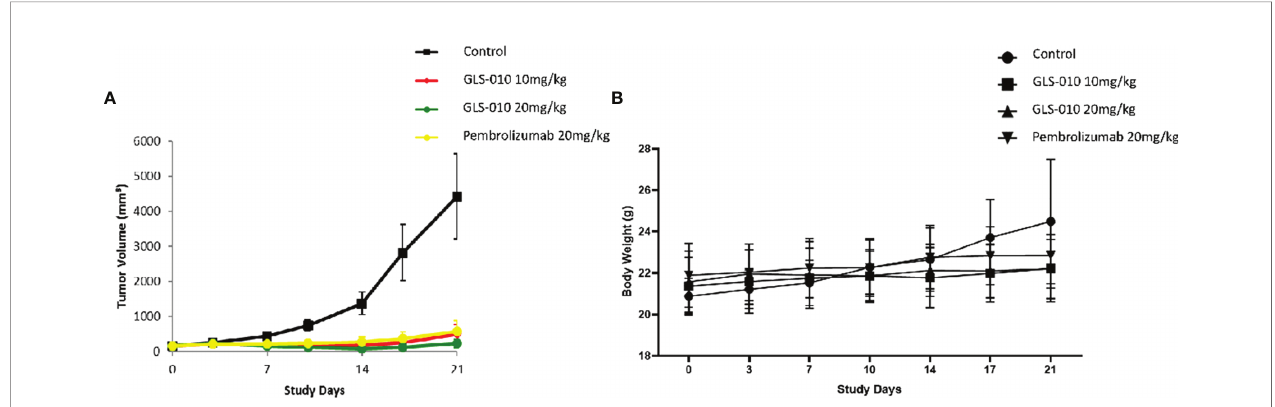
FIGURE 5 | The ef fi cacy of GLS-010 was evaluated in hPD-1 knock-in model with subcutaneous MC38 mouse colon adenocarcinoma. The dosing schedule was BIW*3. (A) Tumor growth inhibition (MC38) in hPD-1 knock-in mice treated with GLS-010. (B) Effect of GLS-010 on mouse body